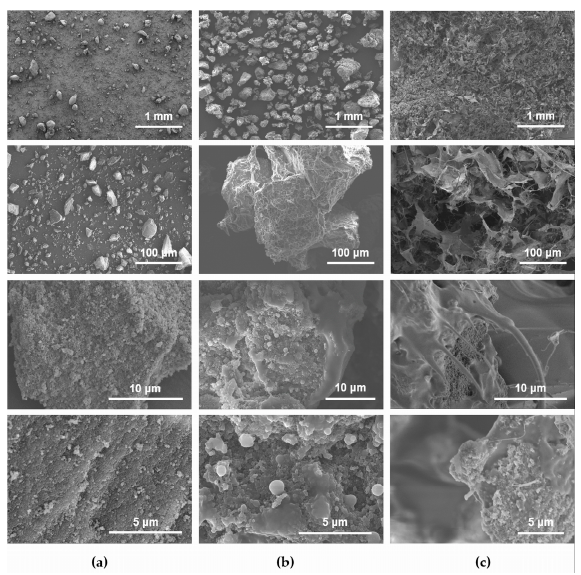
Figure 2. Scanning electron micrographs of ( a ) sepia melanin; ( b ) as-prepared sepia melanin-P(E- alt -MA) hybrid; and ( c ) hybrid’s lyophilized gel.